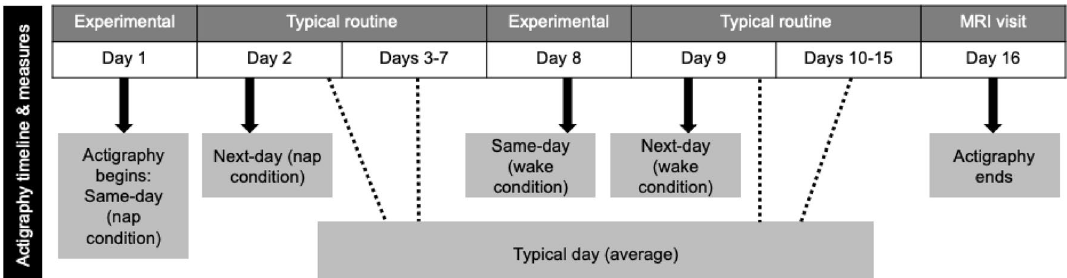
Figure 1. Study overview. Actigraphy was measured throughout the full period. Children followed their normal routines on non-experimental days and ‘typical’ behavior was determined from these days. On days shaded noted as experimental, children were either nap- or wake-promoted in the afternoon (order counter-balanced). Polysomnography was measured during the nap on the nap condition day. Actigraphy for each of the two conditions was determined separately for the same day of the condition (‘same’ day) and for the day immediately following the condition (‘next’